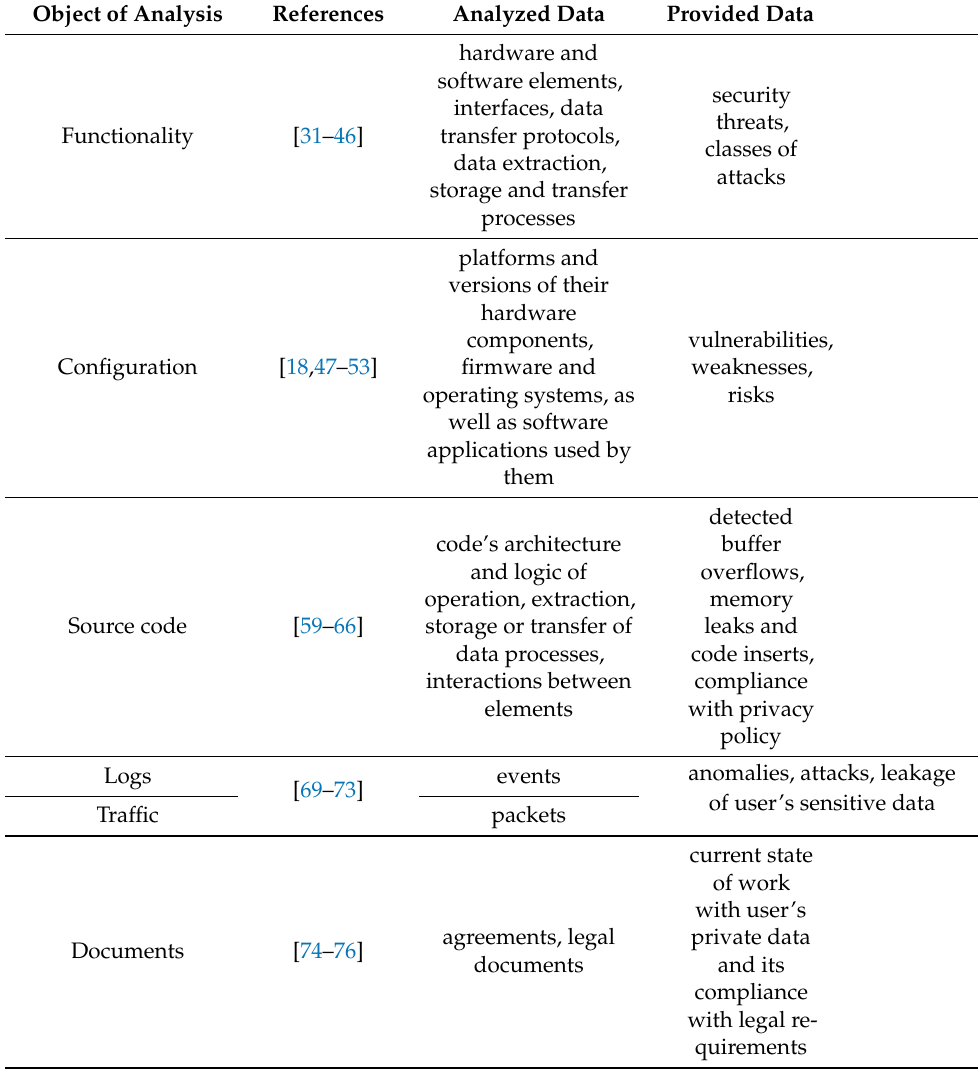
Table 1. Approaches’